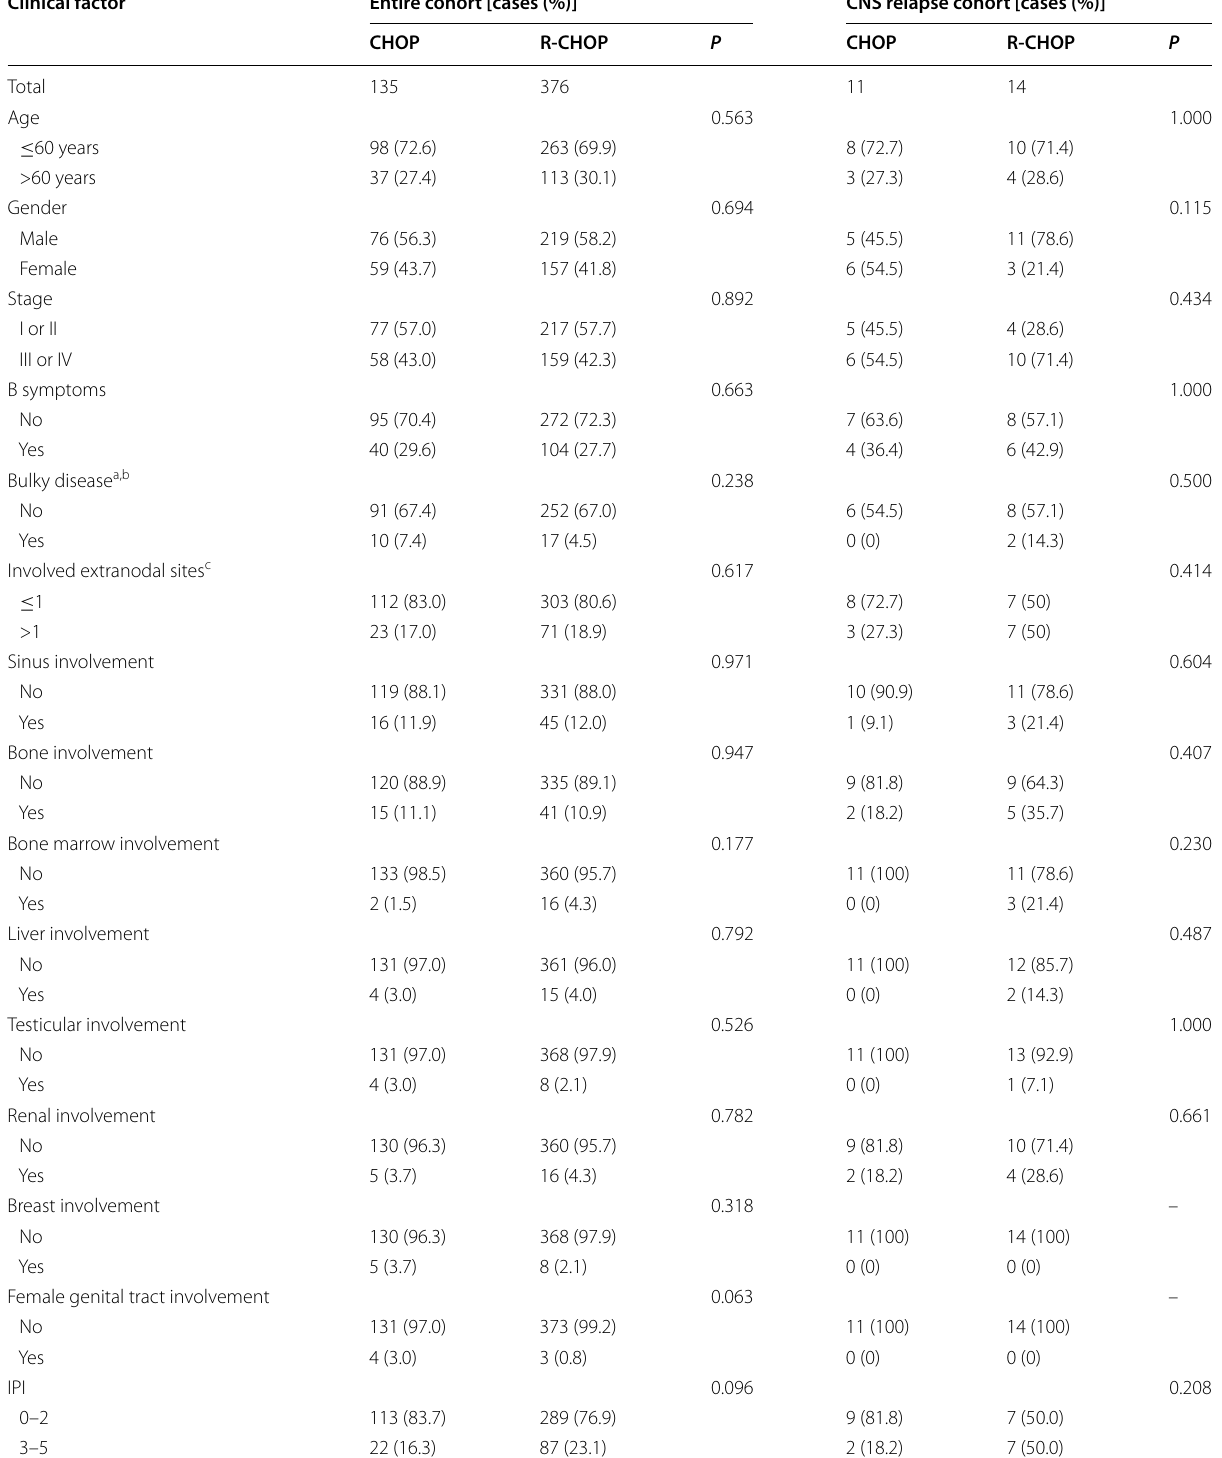
Table 1 Characteristics of the 511 diffuse large B-cell lymphoma (DLBCL) patients in the entire cohort and the